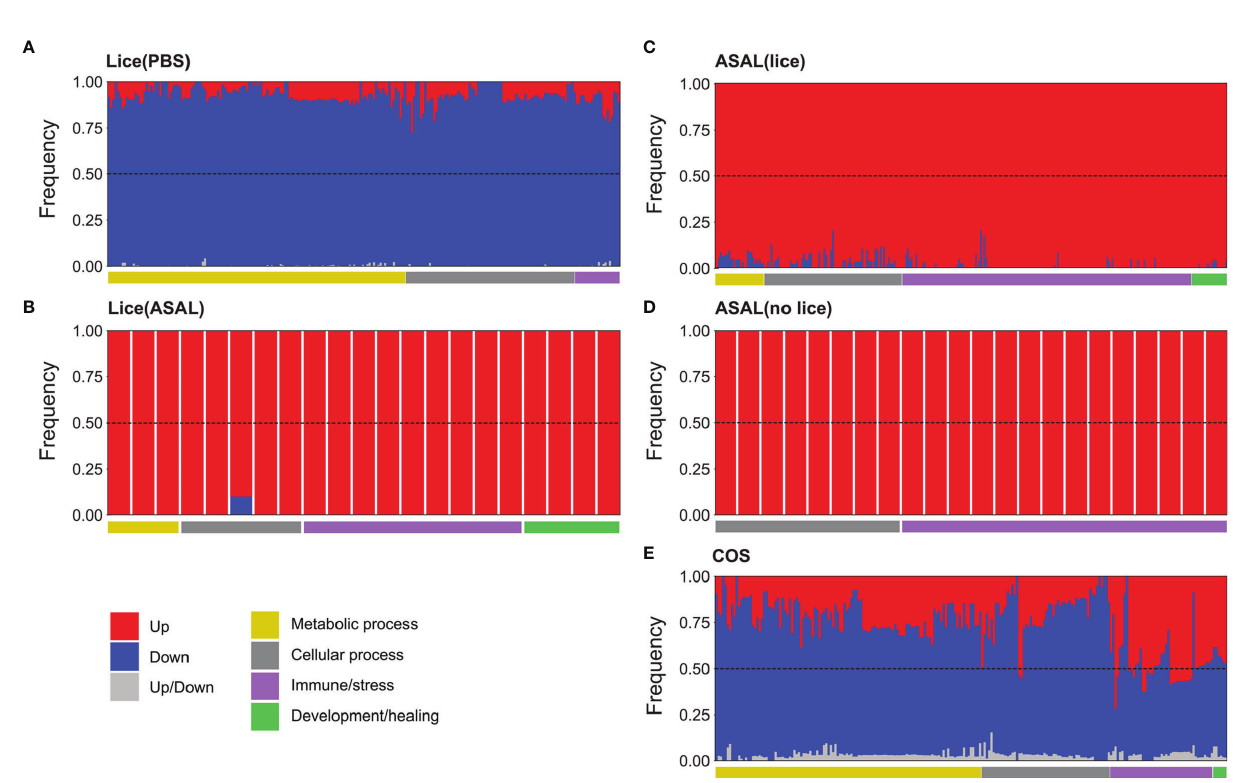
FIGURE 6 | Stacked bar plots showing the relative frequency of differentially expressed genes (DEGs) detected by up-regulated (red) and down-regulated (blue) microarray probes or by both up and down-regulated probes (light grey) for the GO terms over-represented in the (A) Lice(PBS), (B) Lice(ASAL), (C) ASAL(lice), (D) ASAL(no lice), and (E) COS lists. The GO terms are arranged based on their functional theme (e.g., metabolic process, immune/stress; see horizontal bars below the stacked bar